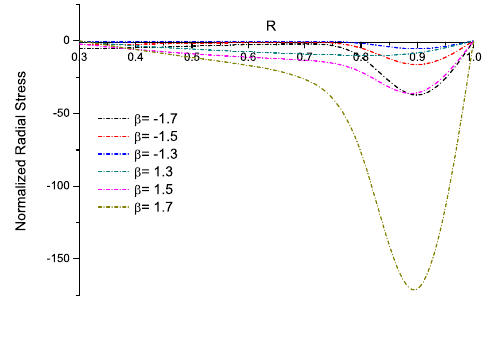
Figure 3: Normalized radial stress and dimensionless radial coordi- nate for different values of β